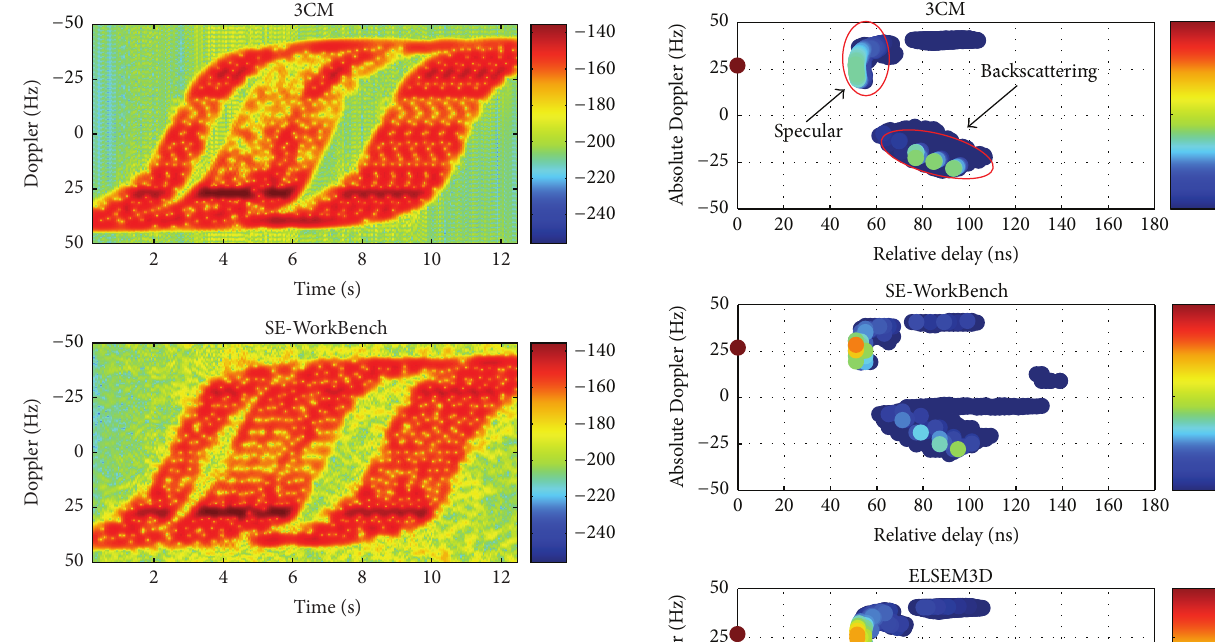
a wide-band validation is here presented. All parameters from the previously described urban scenario are kept constant.